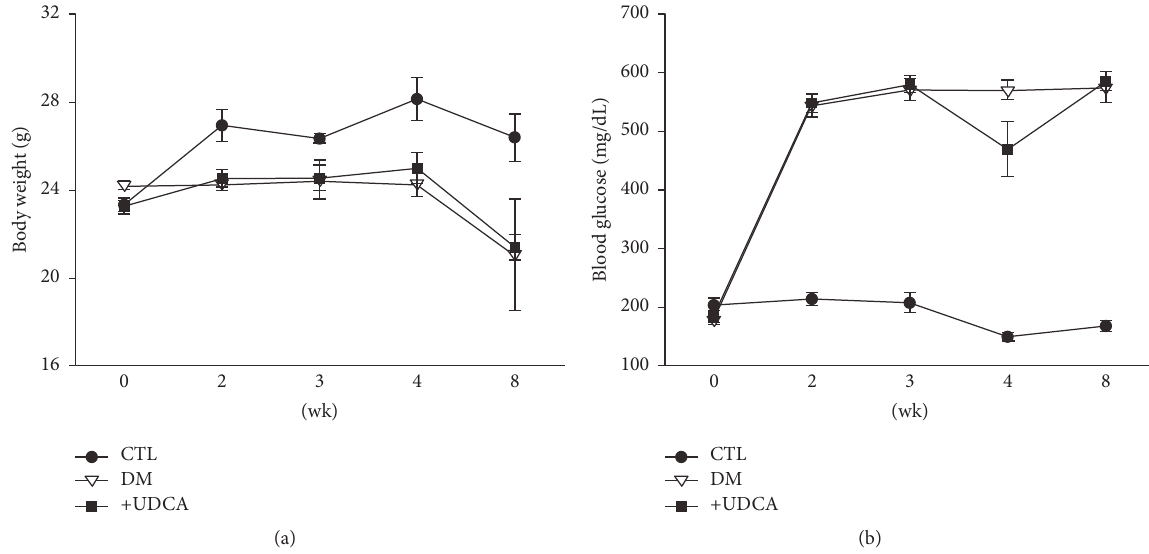
Figure 4: Body weights and blood glucose levels throughout the experimental period. No significant differences were evident in body weight (a) or blood glucose levels (b) between control and diabetic mouse groups with or without UDCA treatment. CTL: control mice, DM: nontreated diabetic mice, and +UDCA: diabetic mice treated with UDCA.